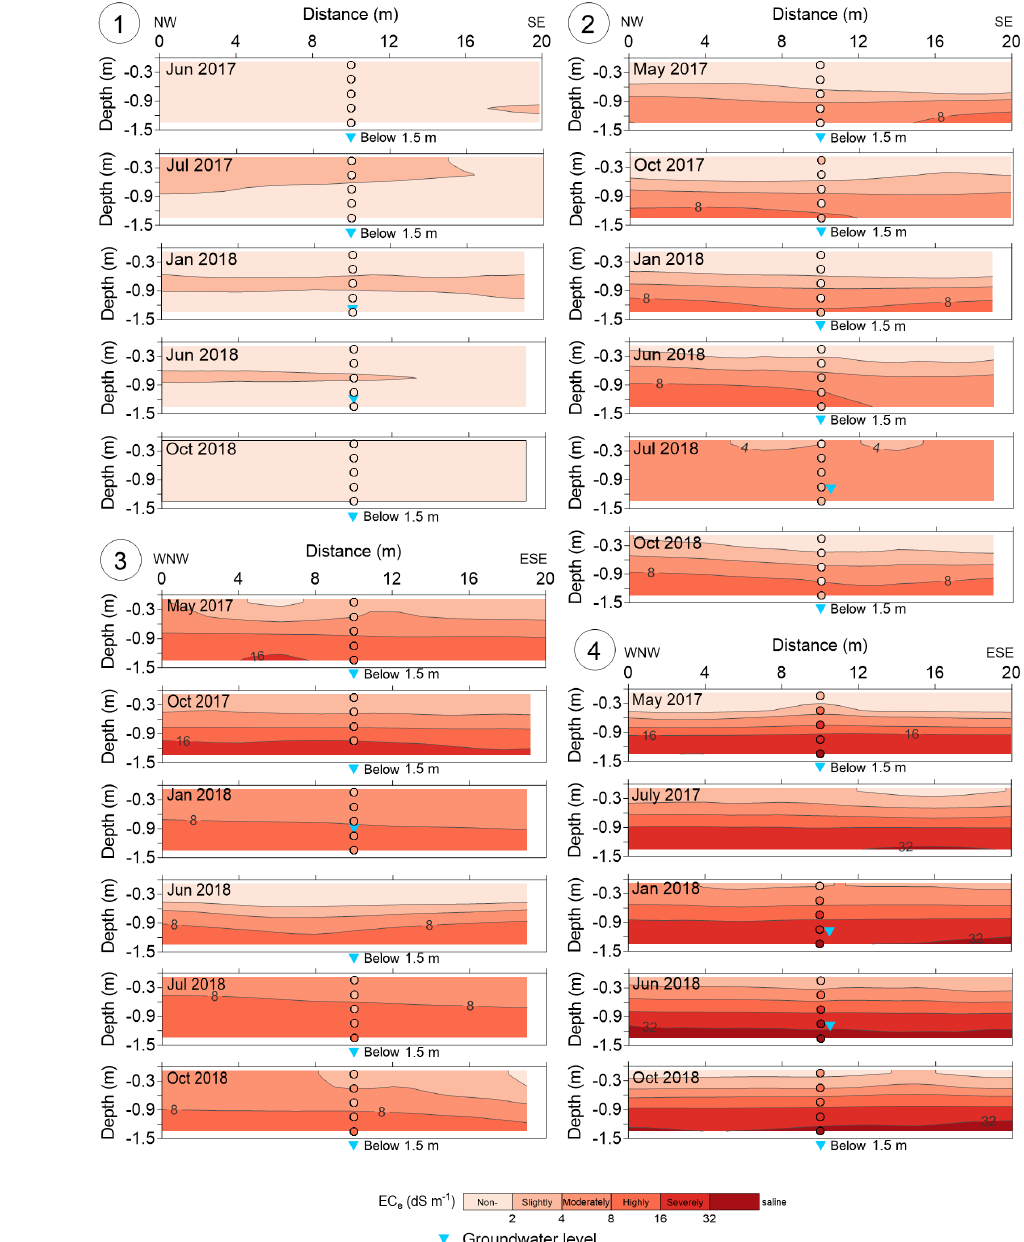
Figure 6. Cross sections of soil salinity (predicted EC e ) for locations 1 to 4, with representation of measured EC e (in circles) and groundwater level (blue triangles) at the sampling sites located in the middle of each transect. Note that in June 2018 at location 3 and in July 2017 at location 4 there was no soil